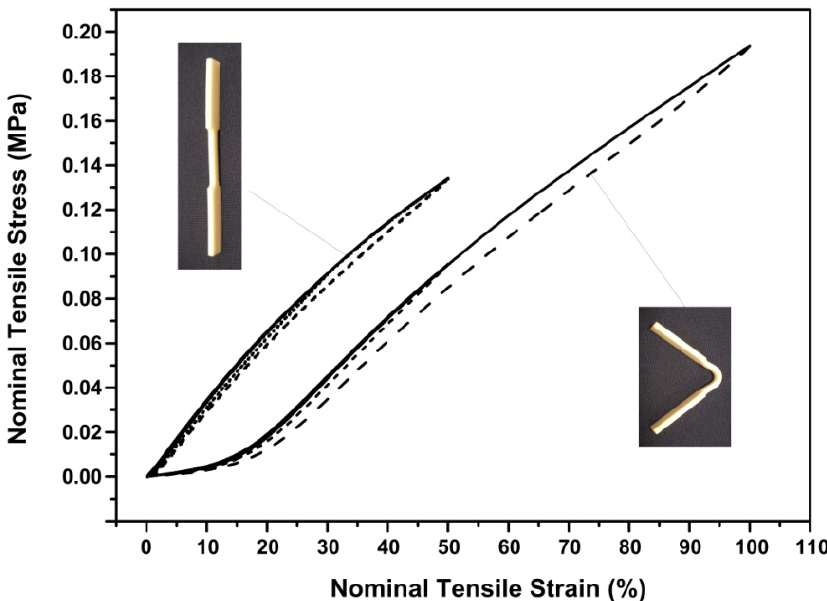
Figure 24. Rubber-like response in cyclic uniaxial tension with (right sample)/without (left sample) programming (bending). (Reproduced with permission from [2]. Copyright 2010 Elsevier).